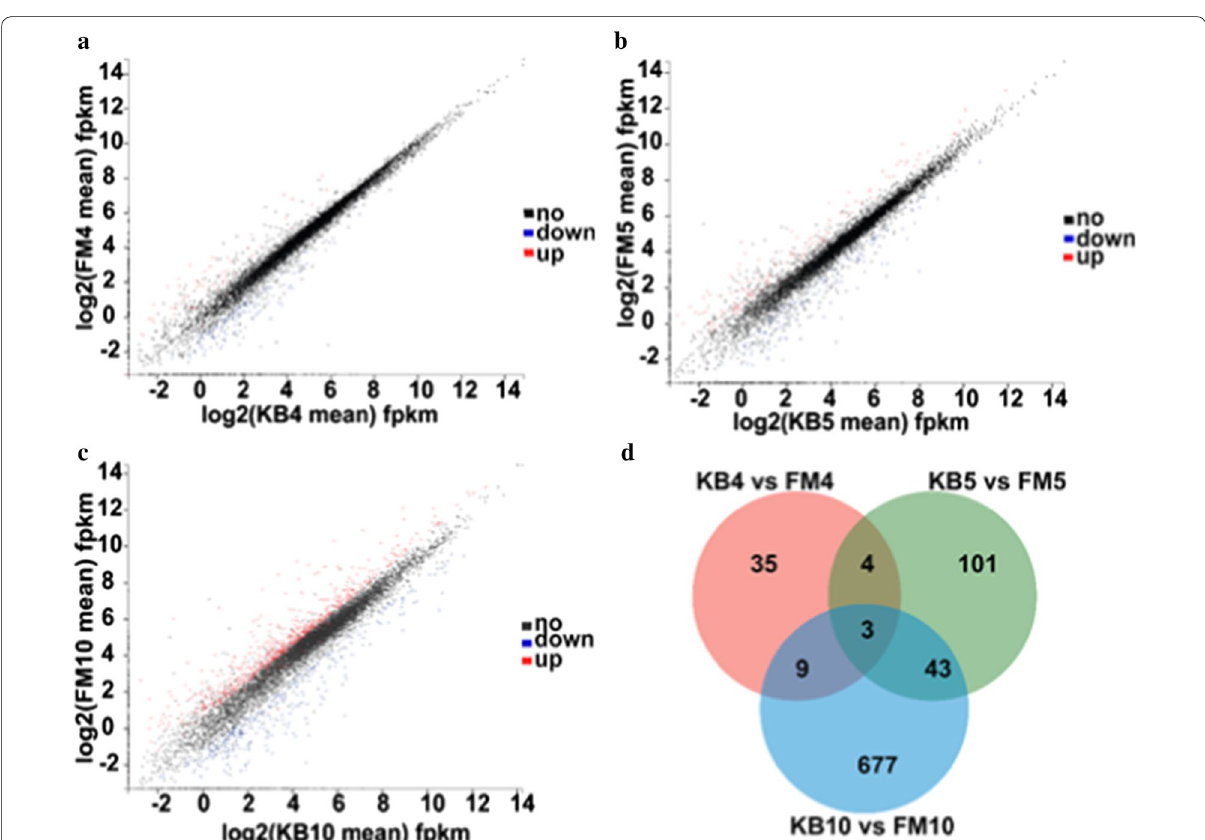
Fig. 1 DEGs between KB and FM. a – c a scatter plot of the DEGs during FM compared with KB on days 4, 5, and 10, respectively. Significantly upregulated or downregulated genes were labeled with red dots or blue dots, respectively. d Venn diagram of the DEGs on days 4, 5, and 10,